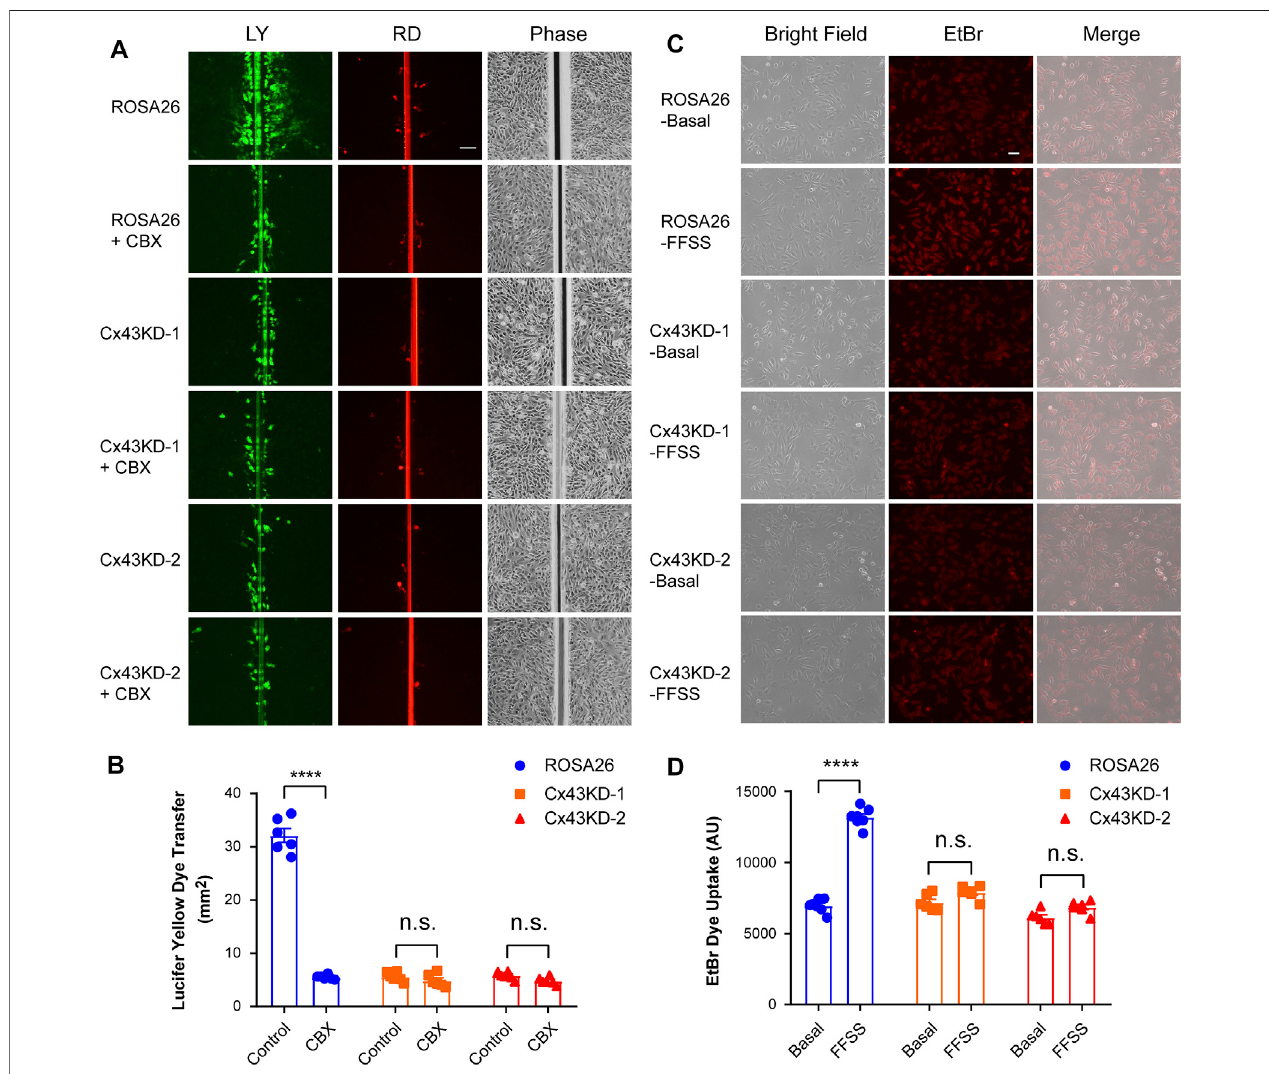
FIGURE 3 | Cx43 de fi ciency in IDG-SW3 cell line inhibits gap junction intercellular communication and the opening of Cx43 hemichannels. (A) Dye transfer was determined in ROSA26 or Cx43 KD IDG-SW3 cells in absence or presence of 100 μ M CBX. The scrape loading assay was performed with LY and RD for 5 min. Scale bar,200 μ m. (B) Areaofdyetransferwasdeterminedandquanti fi edby fl uorescencemicrocopyandNIHImageJsoftware. (C) ROSA26orCx43KDIDG-SW3cellswere subjectedtoFFSSfor10 minornon-FFSSbasalconditions,followedbyincubationwith100 μ MEtBrfor5 min.Scalebar,50 μ m. (D) LevelofEtBrdyeuptakewas determined and quanti fi ed by fl uorescence microcopy and NIH ImageJ software. Data shown are mean ± SEM. ****, p < 0.0001.